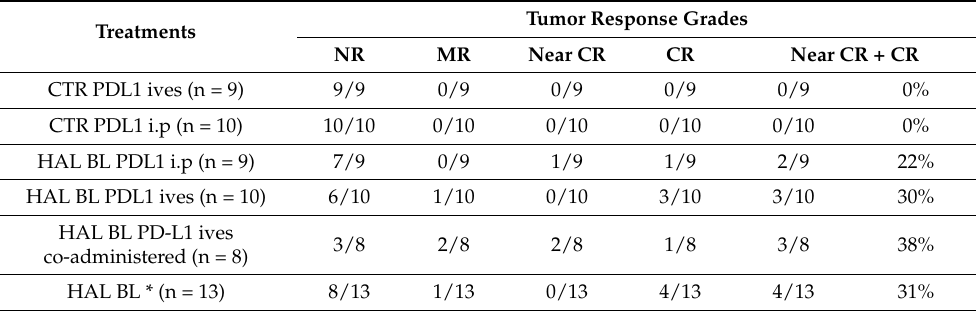
Table 4. HES-assessed anti-tumor effect in rat bladders 30 days after tumor inoculation. Tumor bearing rats were subjected to ives (intravesical) or i.p. (intraperitoneal) anti- PD-L1 immunotherapy.